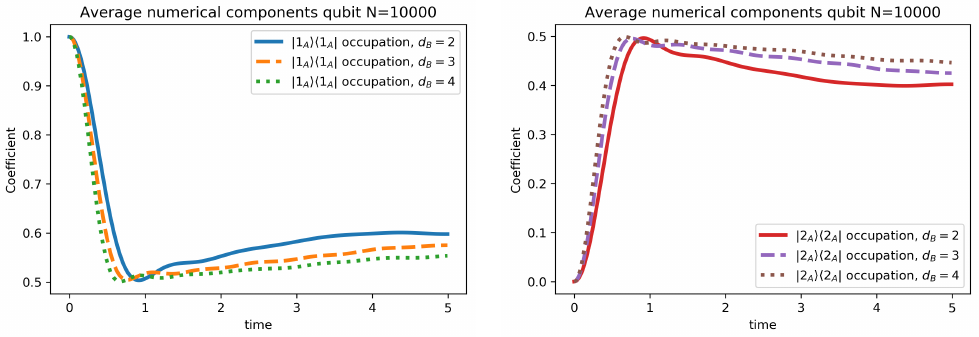
Figure 7: Numerically GUE-averaged coefficients of | 1 of a qubit, coupled to a bath of ∈ { 2,3,4 } . d B